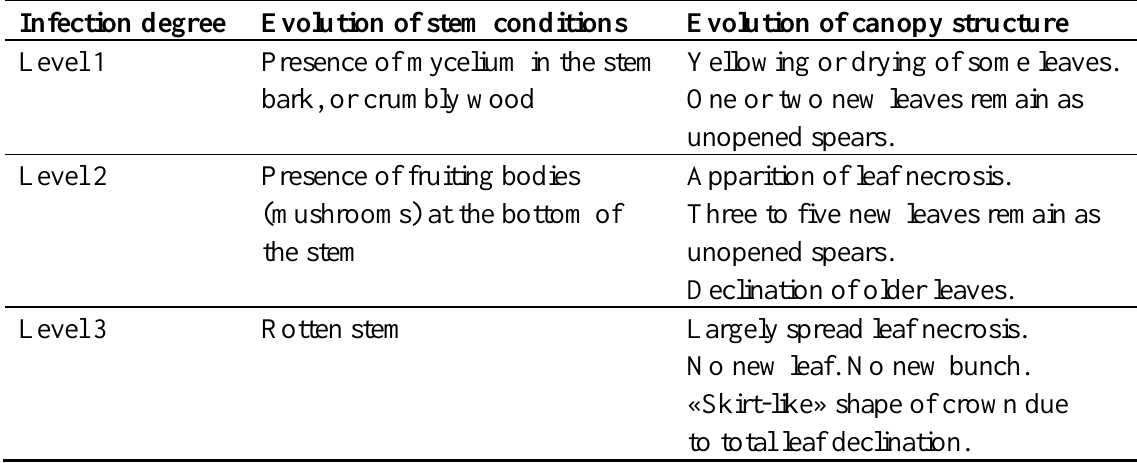
Table 1. Ganoderma-specific visual symptoms used in the fields to classified the trees into the three levels of disease